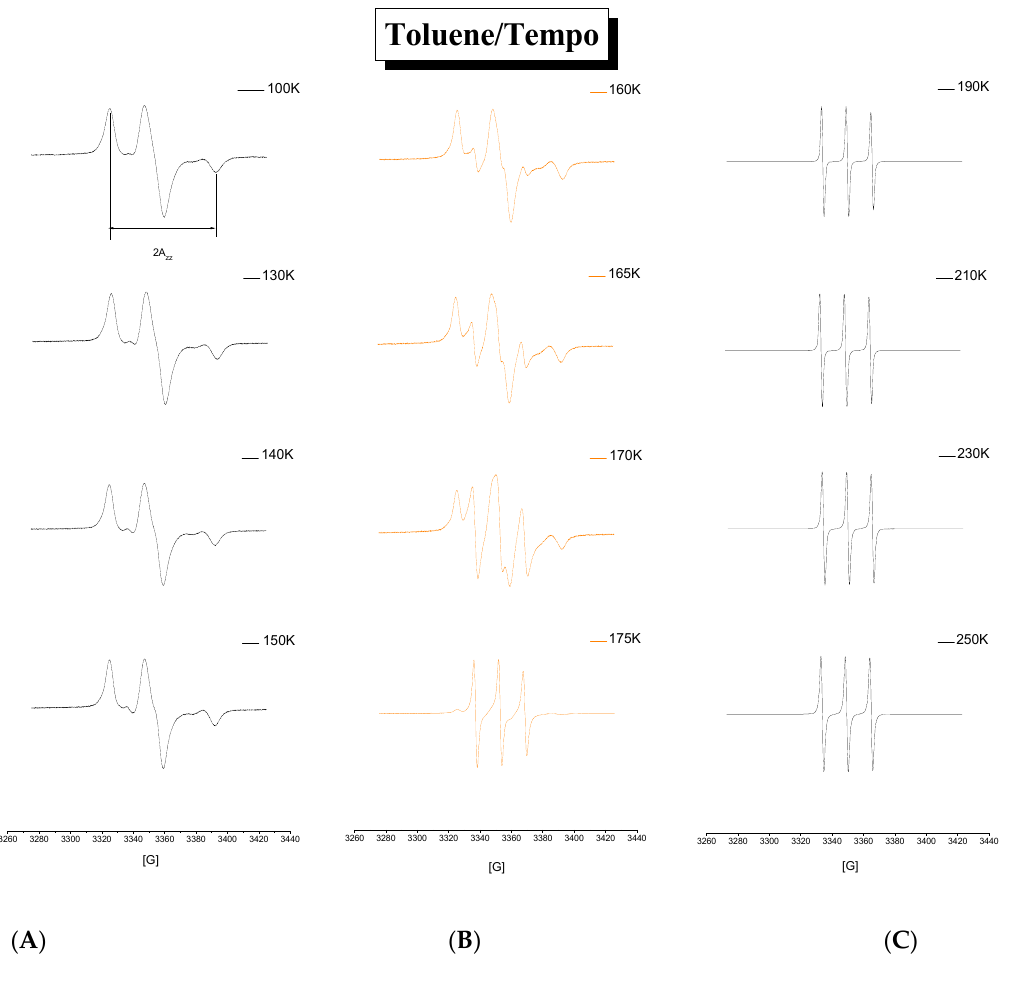
Figure 6. Spectral evolution of the spin TOL/TEMPO system as a function of temperature. Three main regions of the two monomodal ( A , C ) and the one bimodal ( B ) type of spectra are evident.